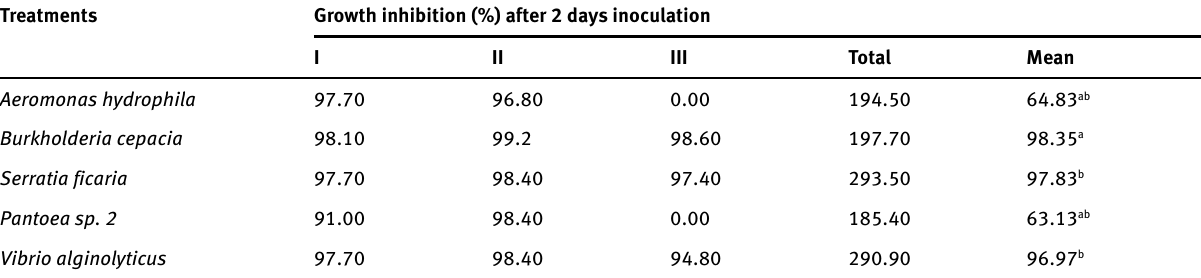
Table 5: In vitro screening antagonism of five PGPR species against Athelia rolfsii